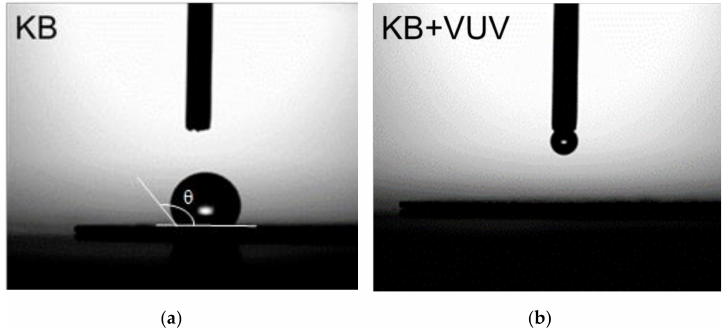
Figure 1. Behavior of a water droplet on ( a ) KB and ( b ) KB + VUV